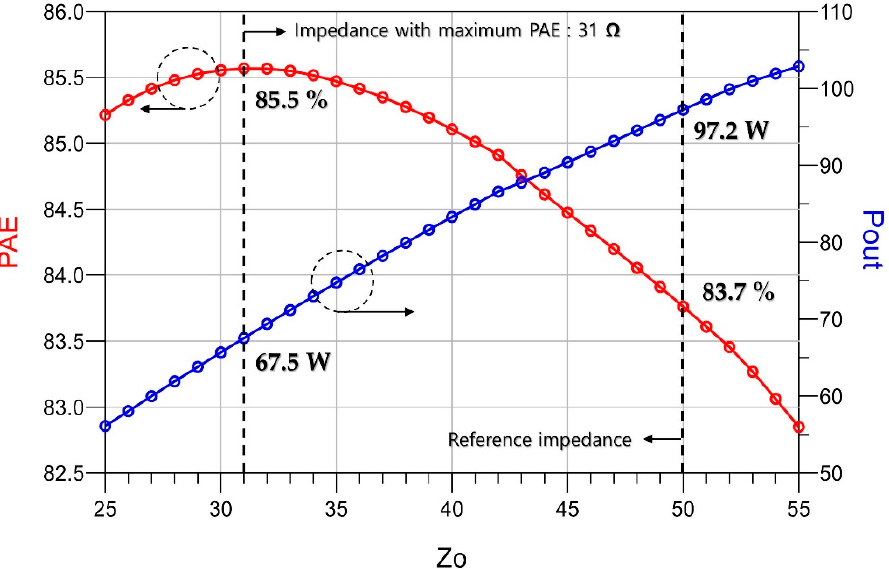
Figure 2. Simulation results of the class-E power amplifier in Figure 1 depending on the load impedance at the output.